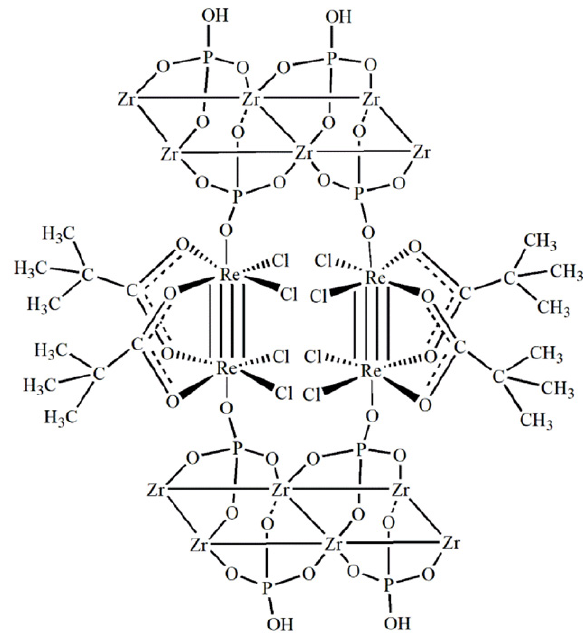
Fig. 3 The proposed formula of the product of the reaction between I and phosphate groups on the surface layers of